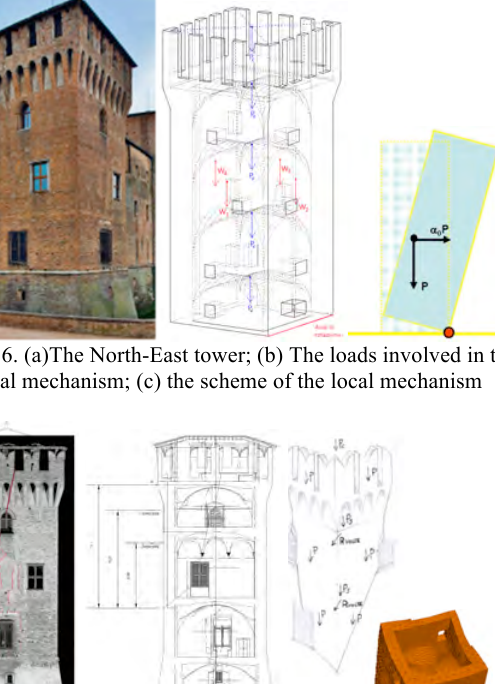
Figure 10. (a) laser scanner survey of the internal side of the chimney; (b) view of the restoration Figure 7. (a)The North-East tower; (b) The section; (c) the scheme of the local mechanism; (d) the corresponding vibration mode